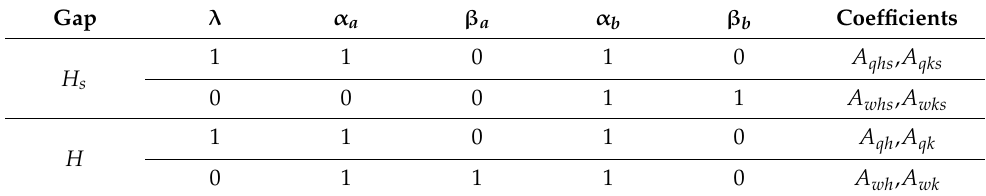
Table 1. Coefficients of transformants for special cases of the boundary value problem (Equation (35)).